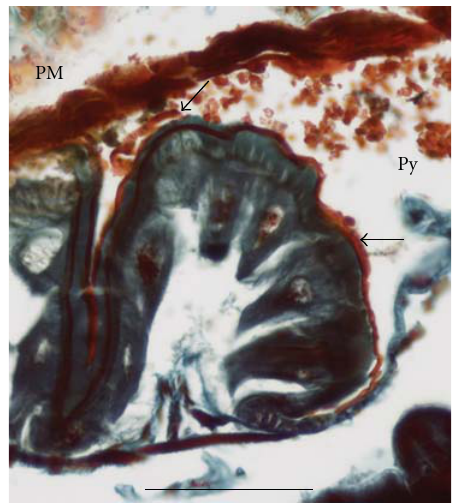
Figure 15: Cells contributing material (arrows) to the peritrophic membranes (PM) at the posterior end of the midgut just anterior of the pylorus (Py). Scale bar = 0.1mm.